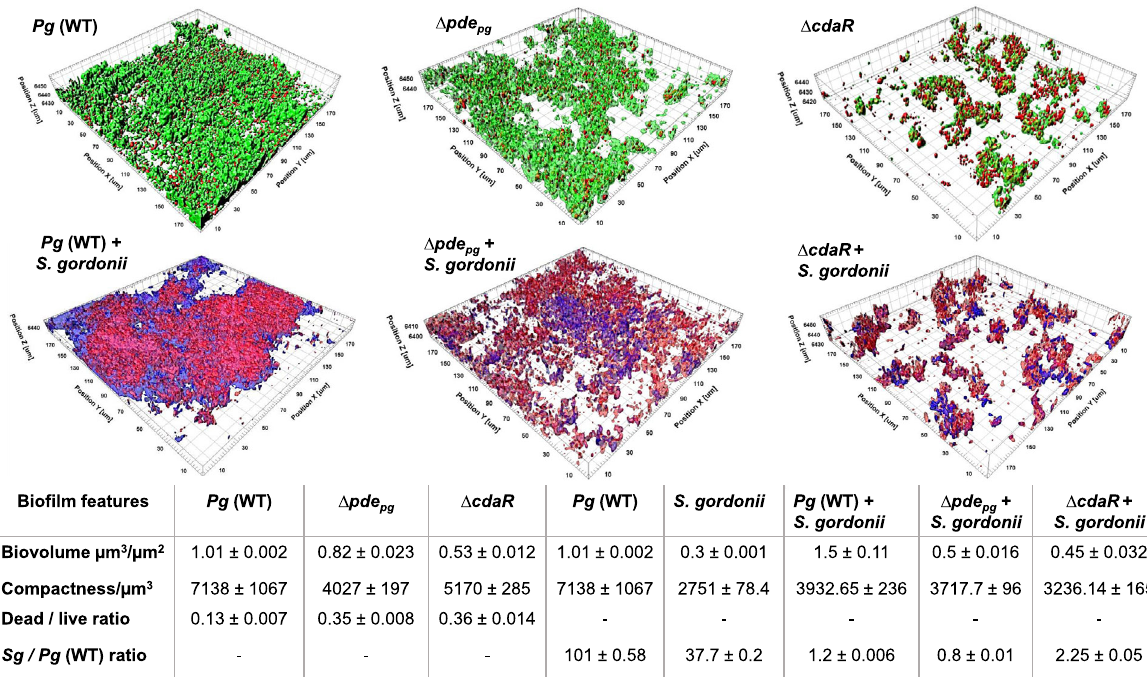
Fig. 4 Effects of defective regulation of c-di-AMP levels on bio fi lm formation of P. gingivalis WT, Δ pde pg , and Δ cdaR and its colocalization with S. gordonii . CLSM images of mono- and dual-species bio fi lms were analyzed by IMARIS image analysis software. The resultant bio fi lm parameters are summarized in the table. The cell community dimensions are provided as µm 3 /µm − 2 and the values of three biological replicates were calculated per unit that represent mean biovolume/unit ± SE, compactness/unit ± SE, dead/live ratio, and S. gordonii / P. gingivalis ratio, as determined by appropriate staining methods. Sg S. gordonii , Pg P. gingivalis , WT